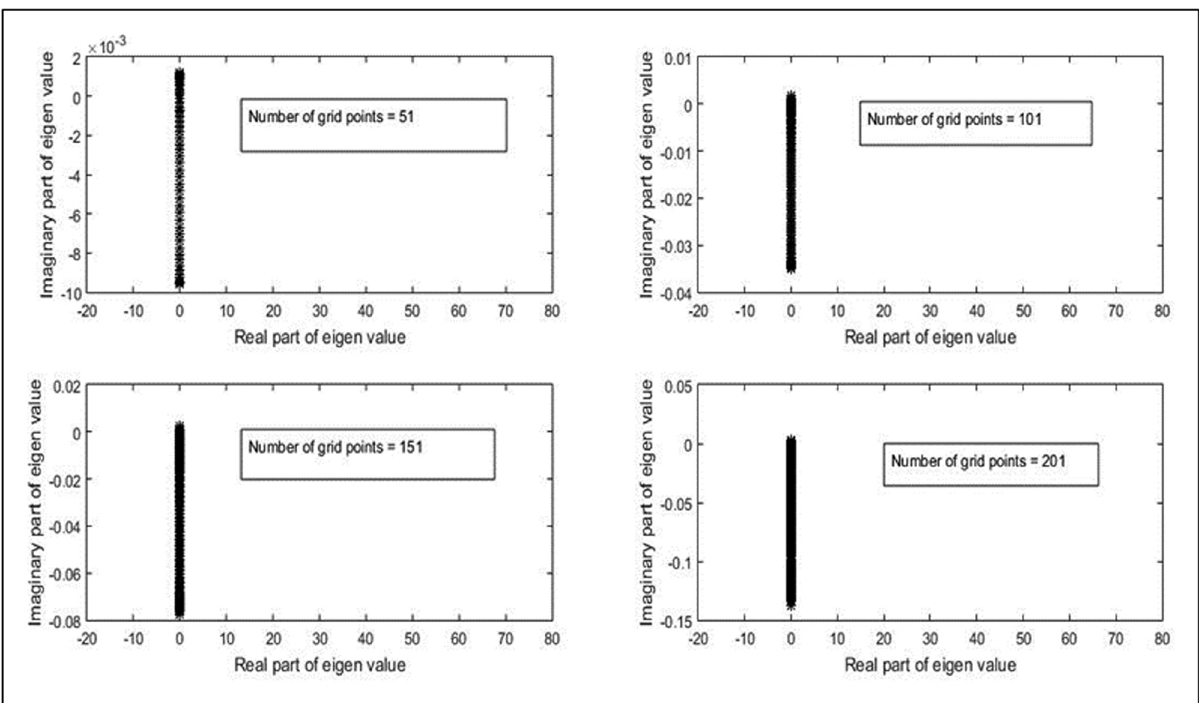
Figure 20: The stability of the present method in one dimension at di ff erent number of grid points.